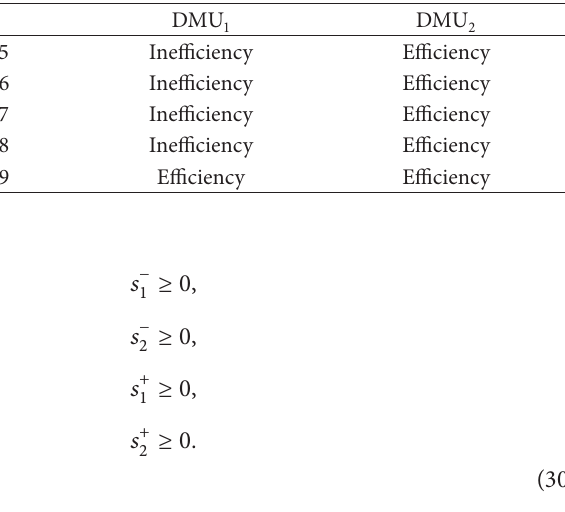
Table 3: Results of evaluating the DMUs with different confidence level 𝛼